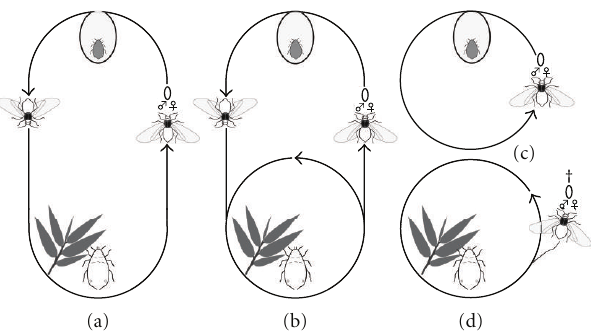
Figure 1: Life cycles of cerataphidines. Gall generation (upper) and secondary-host generation (lower), together with alates (emigrant and sexupara), are schematically shown. (a,b) Host-alternating (heteroecious) life cycle: in obligate host alternation (a) aphids cannot persist without returning to the primary host, while in facultative host alternation (b) aphids can survive on the secondary host throughout the year. (c) Non-host-alternating (monoecious) life cycle on the primary host; alate sexuparae produced in the gall fly to the primary host.